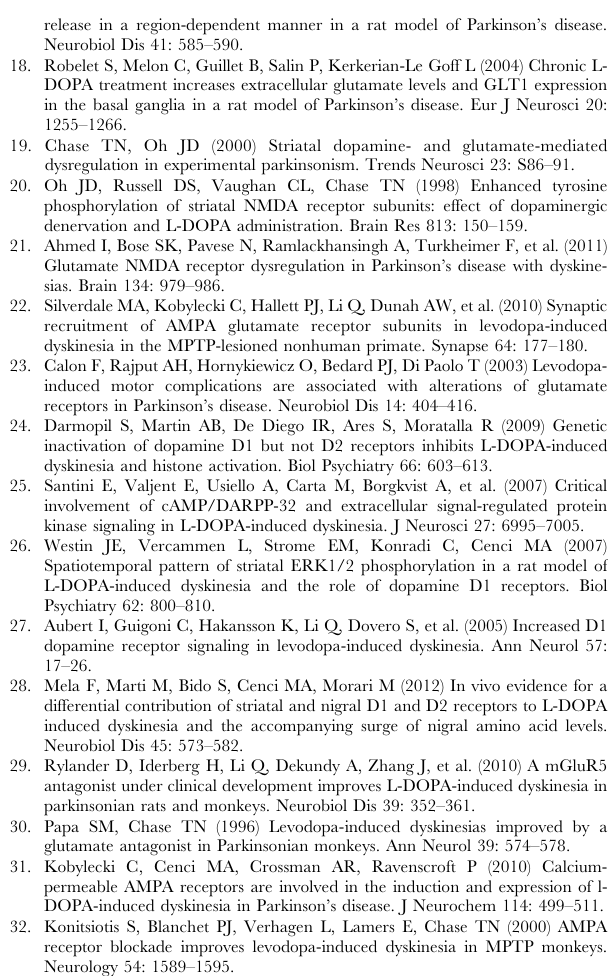
surface. The reporter molecule for the degradation of